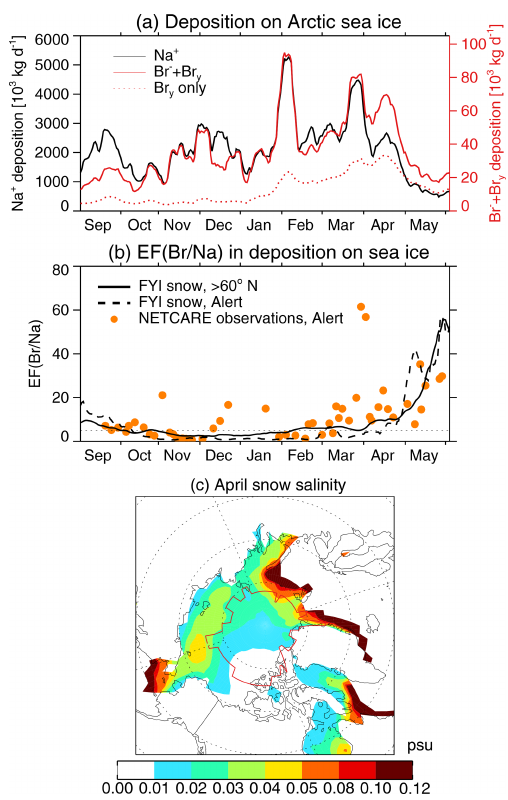
Figure 12. Modeled evolution of the deposition and Br / Na en- richment factor on sea ice ( > 60 ◦ N) for 2007 calculated with the FYI Snow simulation. (a) Total deposition on sea ice (in units of 10 3 kgd − 1 ) for Na + (black line, left axis), Br − + Br y (red line, right axis), and Br y only (dashed red line, right axis). (b) Modeled Br / Na enrichment factor (EF; black line) relative to seawater in deposition over sea ice; see Sect. 5 for the definition of EF. The orange circles show the enrichment factors observed during the NETCARE cam- paign at Alert, Nunavut (Macdonald et al., 2017). The dashed black line is the modeled EF sampled at Alert. A 10d boxcar smoothing has been applied to all the modeled time series between September and May. The horizontal dotted line represents the value EF = 5, as- sumed for the emitted blowing-snow SSA. (c) Surface snow salinity due to the cumulative SSA deposition on sea ice for 1 February– 30 April assuming a 1cm snow accumulation rate for that period (see text). The red line shows the location of